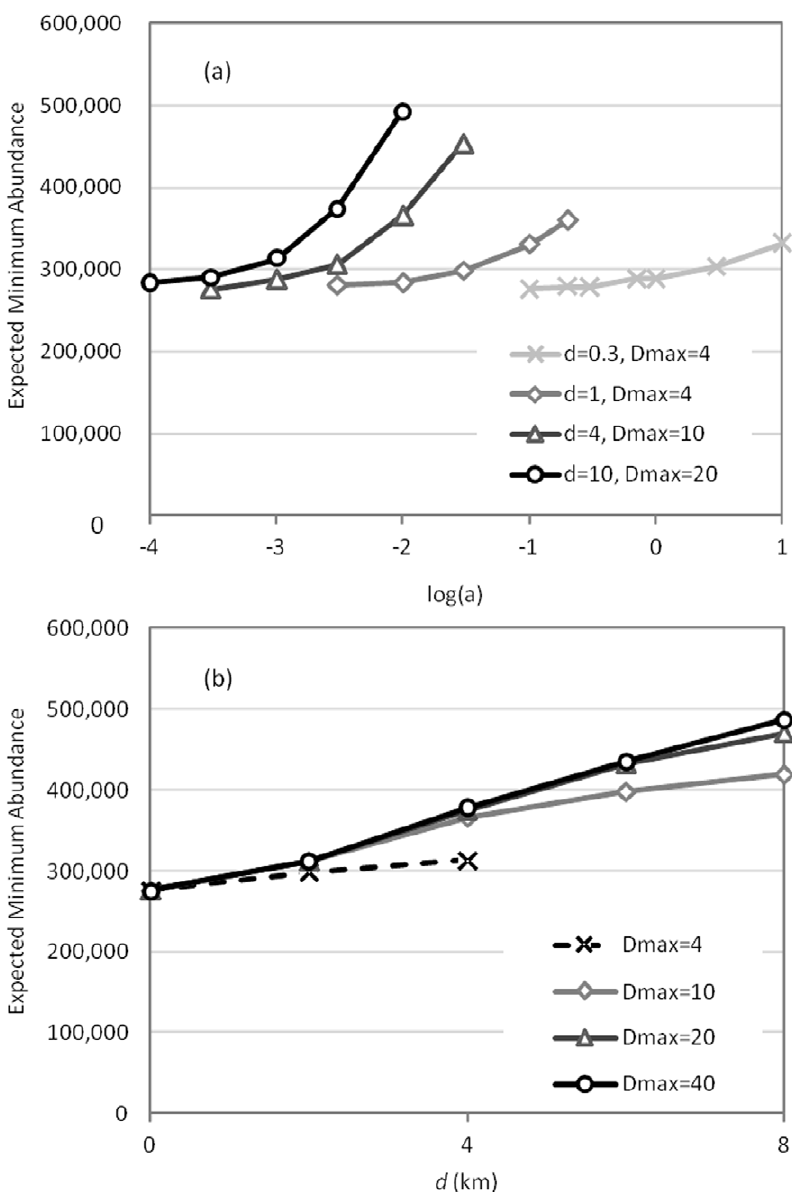
Figure 4. Expected minimum abundance graphed against the dispersal parameters a (logged) and d for a range of dispersal scenarios. Both panels assume the PCM scenario and the absence of fire. In (a), curves are truncated if total dispersal of acorns from a patch exceeds the number of acorns in that patch. In (b), the parameter a is held fixed at 0.01. The dashed line is truncated at d = D max .